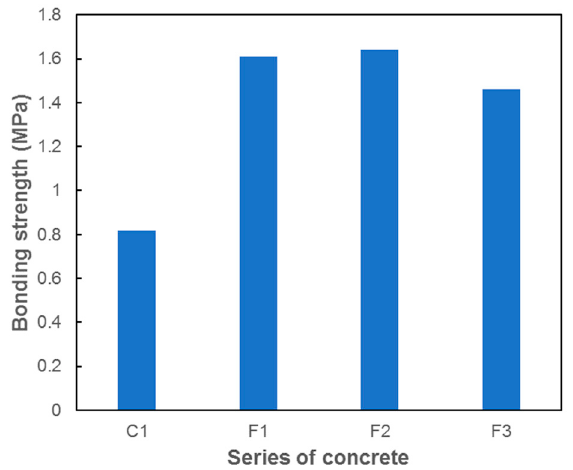
Figure 16. Results of bonding strength tests with regards to the polypropylene fiber content in concrete. C1—concrete without addition, F1—concrete with PP fiber addition in an amount of 0.45 kg / m 3 , F2—concrete with PP fiber addition in an amount of 0.9 kg / m 3 , F3—concrete with PP fiber addition in an amount of 1.35 kg / m 3 (based on the results presented in Reference [73]).